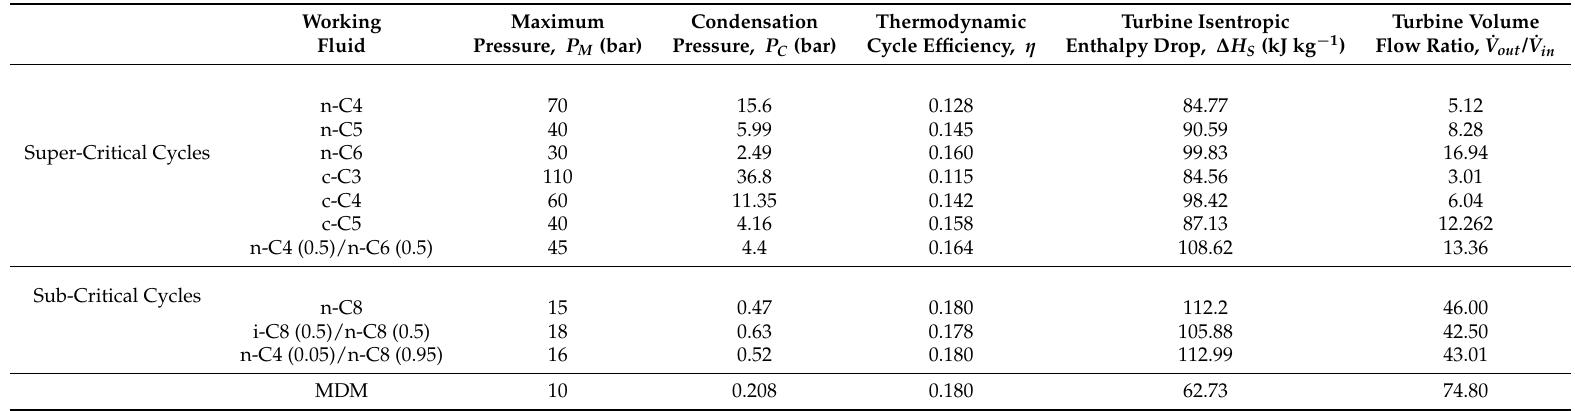
Table 4. Some results for supercritical and subcritical thermodynamic cycles. The results for MDM are reported as a